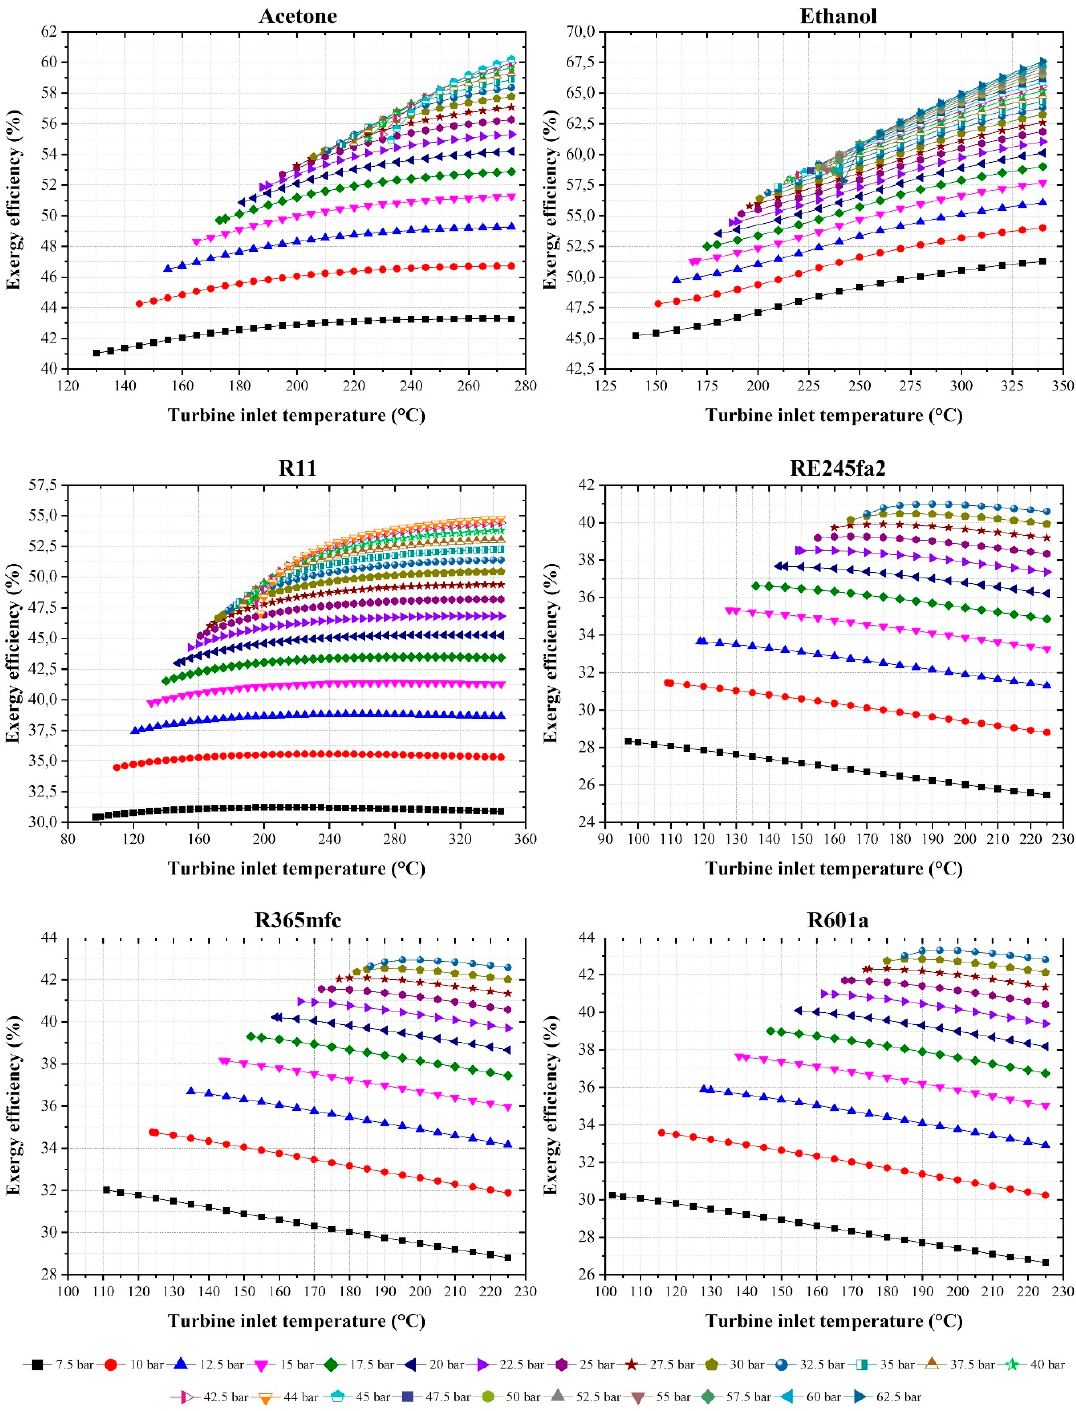
Figure 8. The exergy efficiency calculated from the ORC for varying turbine inlet temperatures and turbine inlet pressures.